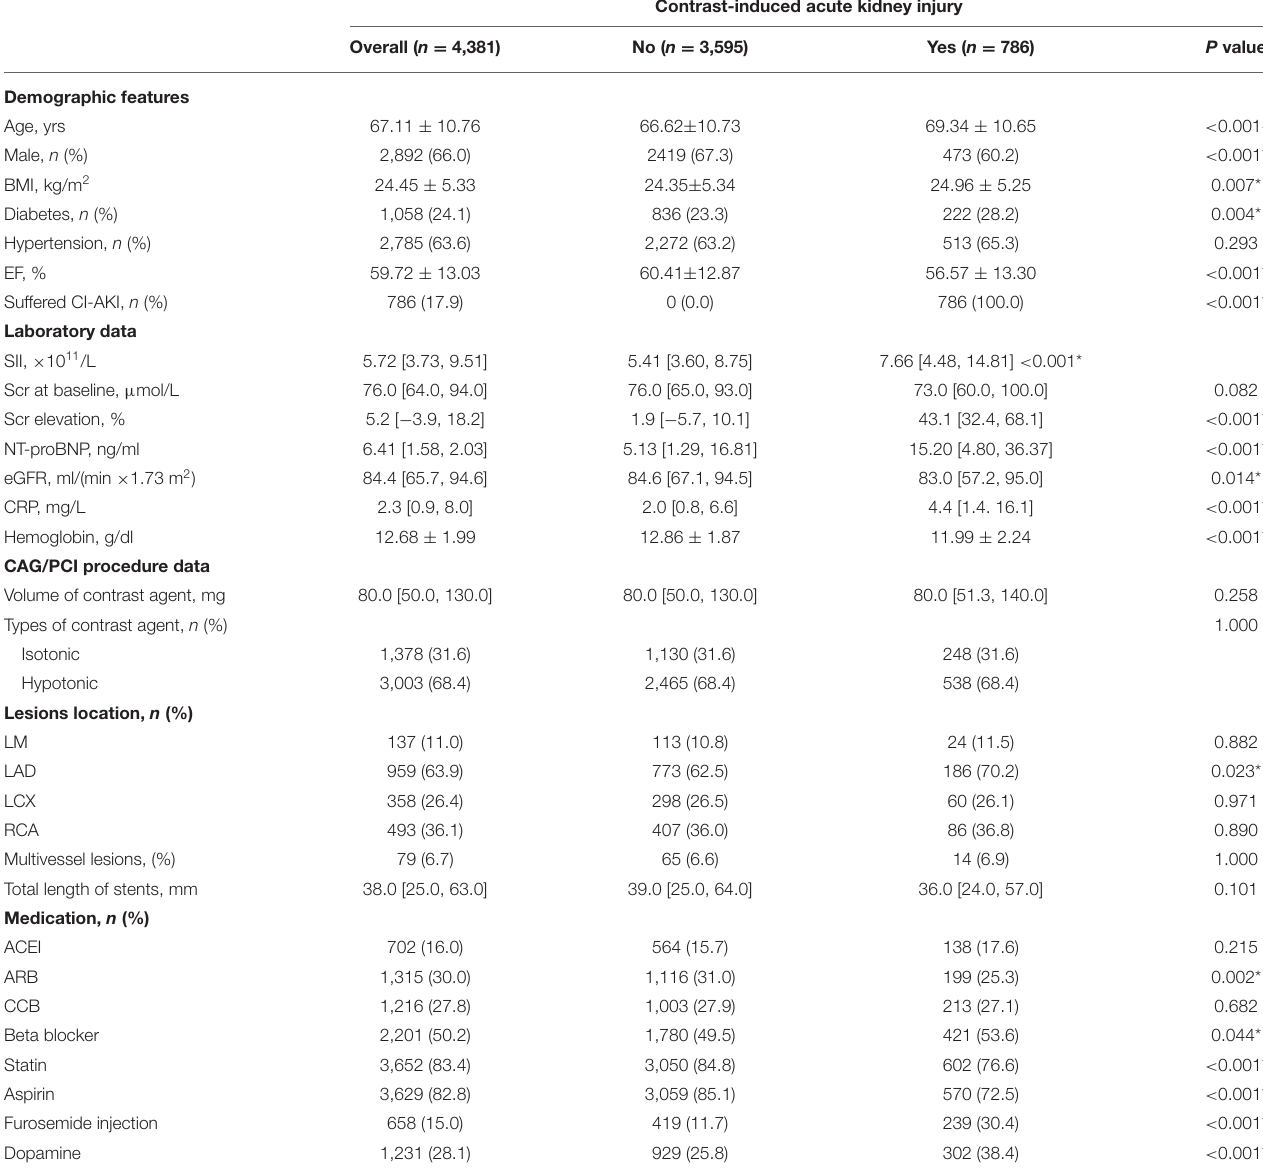
TABLE 1 | Baseline characteristics of patients according to SII and